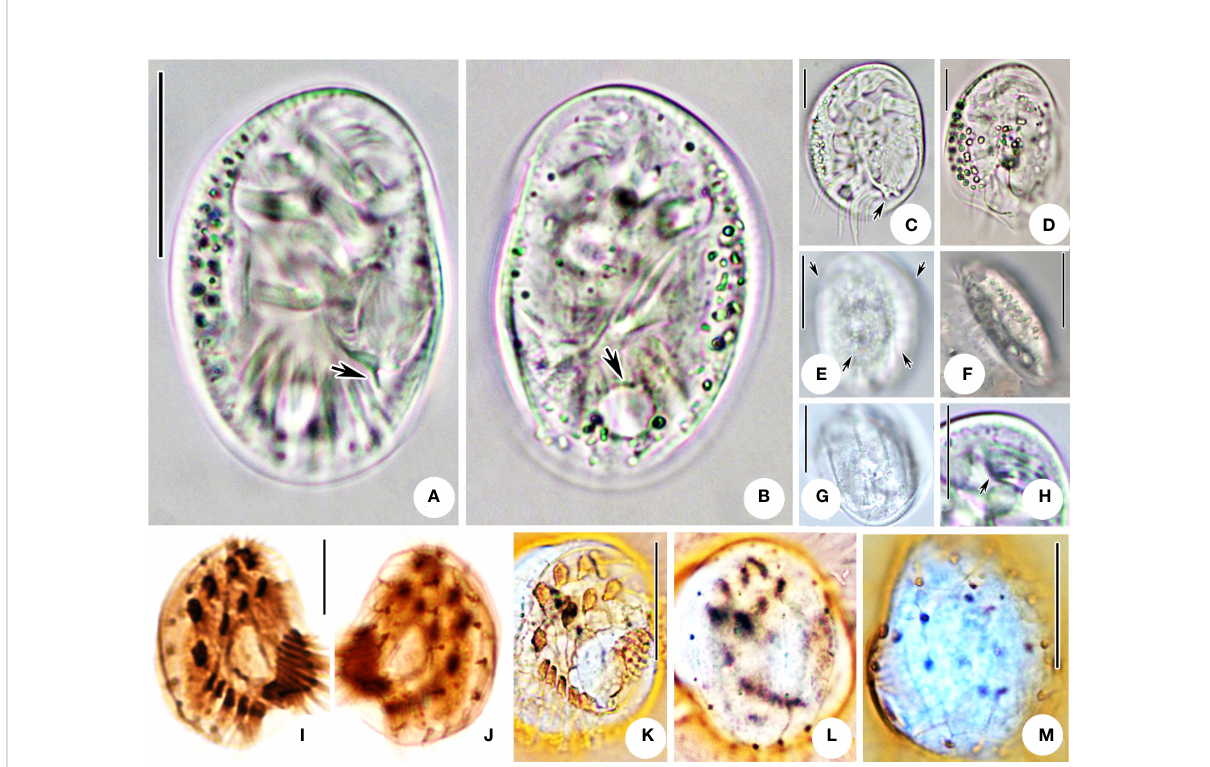
FIGURE 5 Microphotographs of Aspidisca shini sp. n. in life (A – H) , after protargol impregnation (I, J) and silver nitrate impregnation (K – M) . (A) Ventral view of a representative individual; arrow indicates the protrusion. (B) Dorsal view, arrow indicates the contractile vacuole. (C, D) Cells with different shapes; arrow indicates the protrusion. (E) Dorsal view; arrows indicate the ridges. (F, G) Lateral (F) and apical (G) views of two individuals. (H) Ventral view of the anterior part of the cell, arrow showing the AZM1. (I, J) Infraciliature of ventral (I) and dorsal (J) sides of the specimens. (K – M) Silver nitrate impregnation of ventral (K) and dorsal (L, M) sides. Scale bars: 20 µm (A, B, E – G, K – M) , 10 µm (C, D, H – J)